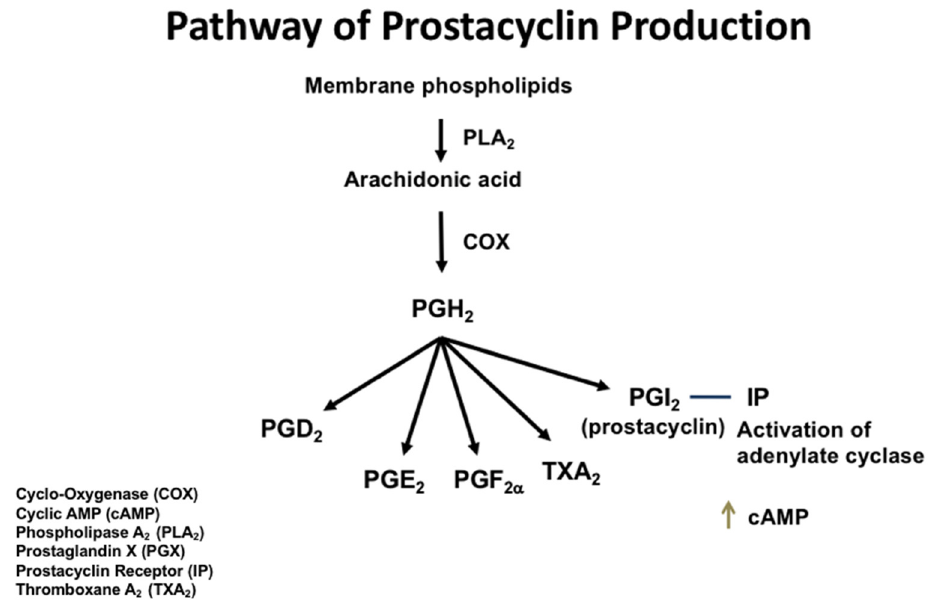
Figure 1. Thepathwayofprostacyclinproduction. Figure 1. The pathway of prostacyclin production. The arrows show the downstream enzymatic pathways.